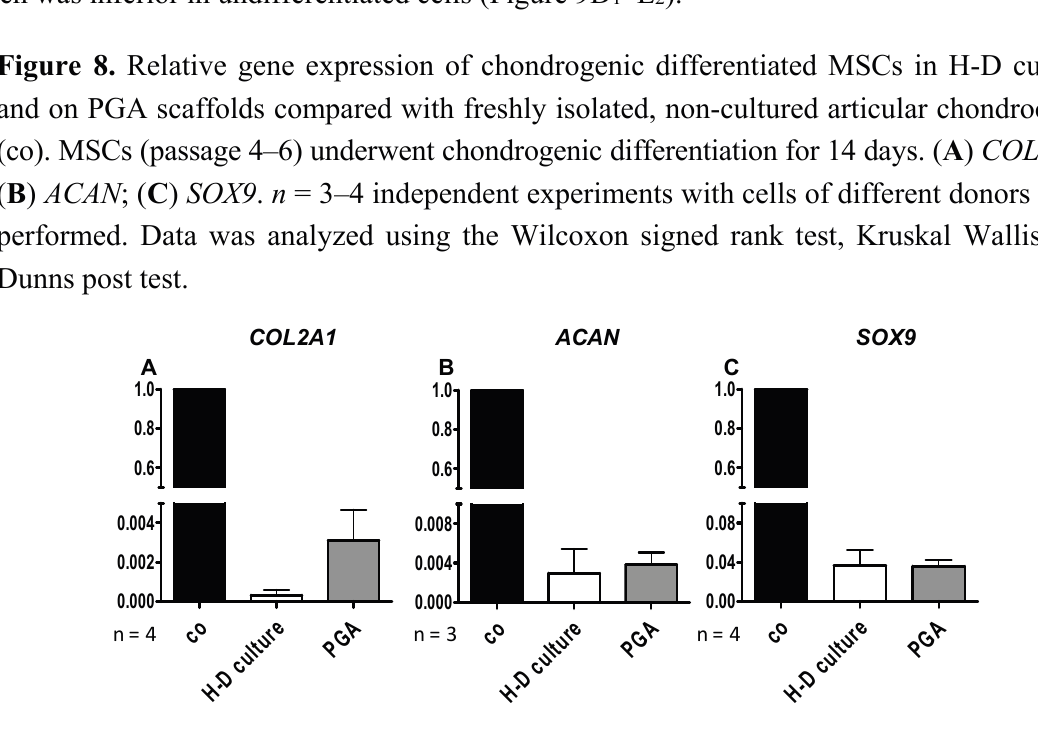
Figure 9. Vitality, histology and type II collagen expression of chondrogenically differentiated and undifferentiated MSCs on PGA scaffolds. Undifferentiated ( − ) and chondrogenically differentiated (+) MSCs were cultured in PGA. ( A (“native”) of undifferentiated and chondrogenically differentiated MSCs in PGA, ( B MSCs stained with FDA/PI, dead cells and PGA fibers are red and viable cells are green, , C ) HE, ( D , D ) alcian blue or immunolabelled for type II collagen ( E ( C 1 2 1 2 and alcian blue staining the fibers and cell nuclei are stained violet. Cell nuclei were counterstained using DAPI (blue). Scale bars = 200 µm ( A